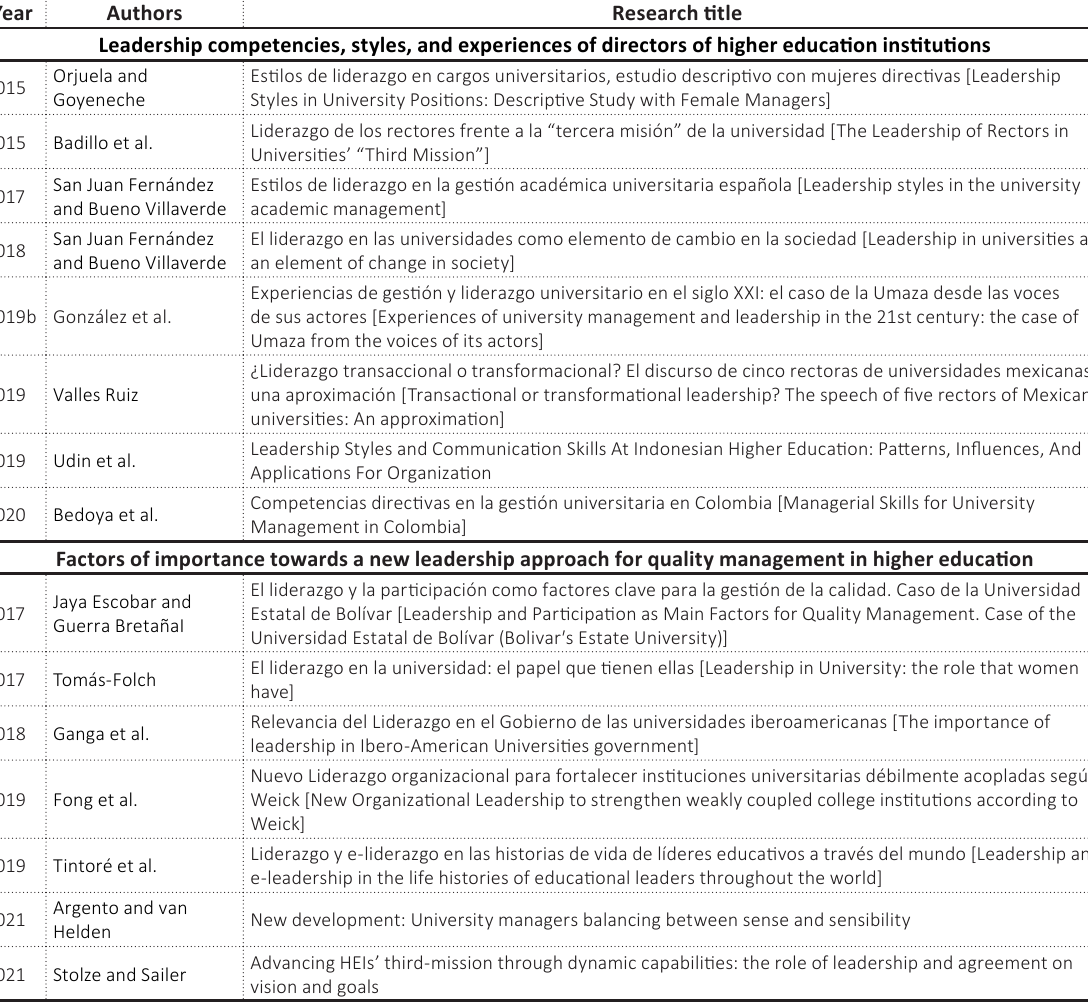
Table 2. Research studies on leadership in higher